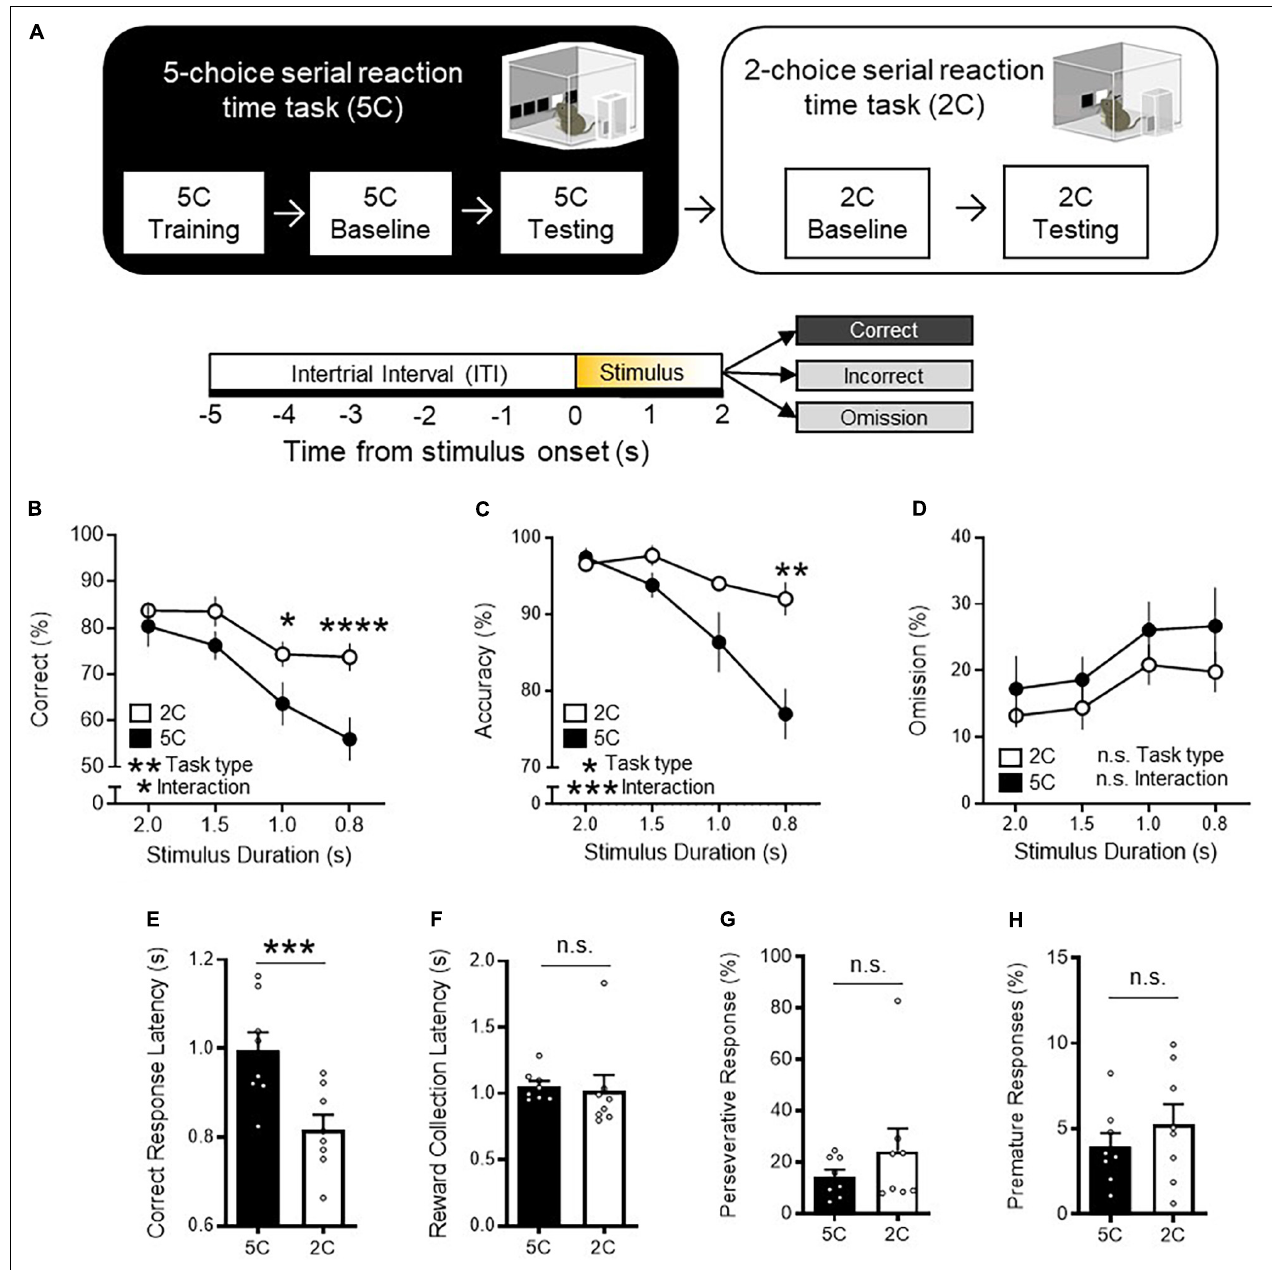
FIGURE 1 | 2CSRTT is less task demanding than the 5CSRTT. (A) Experimental timeline: Mice were first trained on the 5CSRTT before undergoing 5CSRTT testing. During 5CSRTT testing, with a fixed 5 s ITI and pseudorandomized stimulus duration (2.0, 1.5, 1.0, or 0.8 s), (8 mice; 2,161 total trials). The same mice were then baselined with 2CSRTT before undergoing 2CSRTT testing (2,354 total trials). (B) Mice had a significantly increased correct trials during the 2CSRTT compared to the 5CSRTT (%, two-way repeated measures analysis of variance (RM ANOVA), Main effect (task type) F ( 1 , 7 ) = 15.26, ** P = 0.0059, Main effect (stimulus duration): F ( 3 , 21 ) = 29.48, P < 0.0001, Interaction: F ( 3 , 21 ) = 3.626, * P = 0.0298, Holm-Sidak multiple comparisons at 2.0, 1.5, 1.0, 0.8 s stimulus duration, P = 0.7623, 0.1197, *0.0121, **** < 0.0001, n = 8 mice). (C) Mice had a significantly increased accuracy during the 2CSRTT compared to the 5CSRTT (%, two-way RM ANOVA, Main effect (task type): F ( 1 , 7 ) = 11.40, * P = 0.0118, Main effect (stimulus duration): F ( 1 . 53 , 10 . 71 ) = 31.92, P < 0.0001, Interaction: F ( 3 , 21 ) = 10.64, *** P = 0.0002, Holm-Sidak multiple comparisons at 2.0, 1.5, 1.0, 0.8 s stimulus duration, P = 0.9781, 0.2574, 0.3198, **0.0017, n = 8 mice). (D) Mice had no difference in omissions during the 2CSRTT compared to the 5CSRTT (%, two-way RM ANOVA, Main effect (task type): F ( 1 , 7 ) = 3.246, P = 0.1146, Main effect (stimulus duration): F ( 3 , 21 ) = 9.526, P = 0.0004 Interaction: F ( 3 , 21 ) = 0.2317, P = 0.8733, n = 8 mice). (E) The 2CSRTT had a significantly reduced correct response latency compared to the 5CSRTT ( t 7 = 7.193, *** P = 0.0002). (F–H) No difference in (F) reward collection latency ( t 7 = 0.3012, P = 0.7720), (G) premature responses ( t 7 = 1.066, P = 0.3218), and (H) perseverative responses ( t 7 = 1.291, P = 0.2377) was observed between 2CSRTT and 5CSRTT testing. Error bars indicate mean ± SEM. n.s., non-significant. * indicates P < 0.05, ** indicates P < 0.01, *** indicates P < 0.001, **** indicates P < 0.0001.